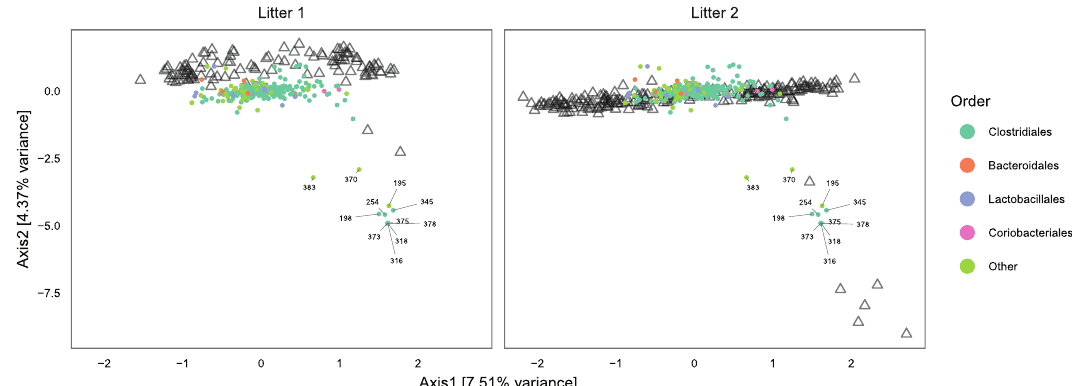
Figure 18. The analogue to Figure 17, faceting by litter membership rather than age bin.